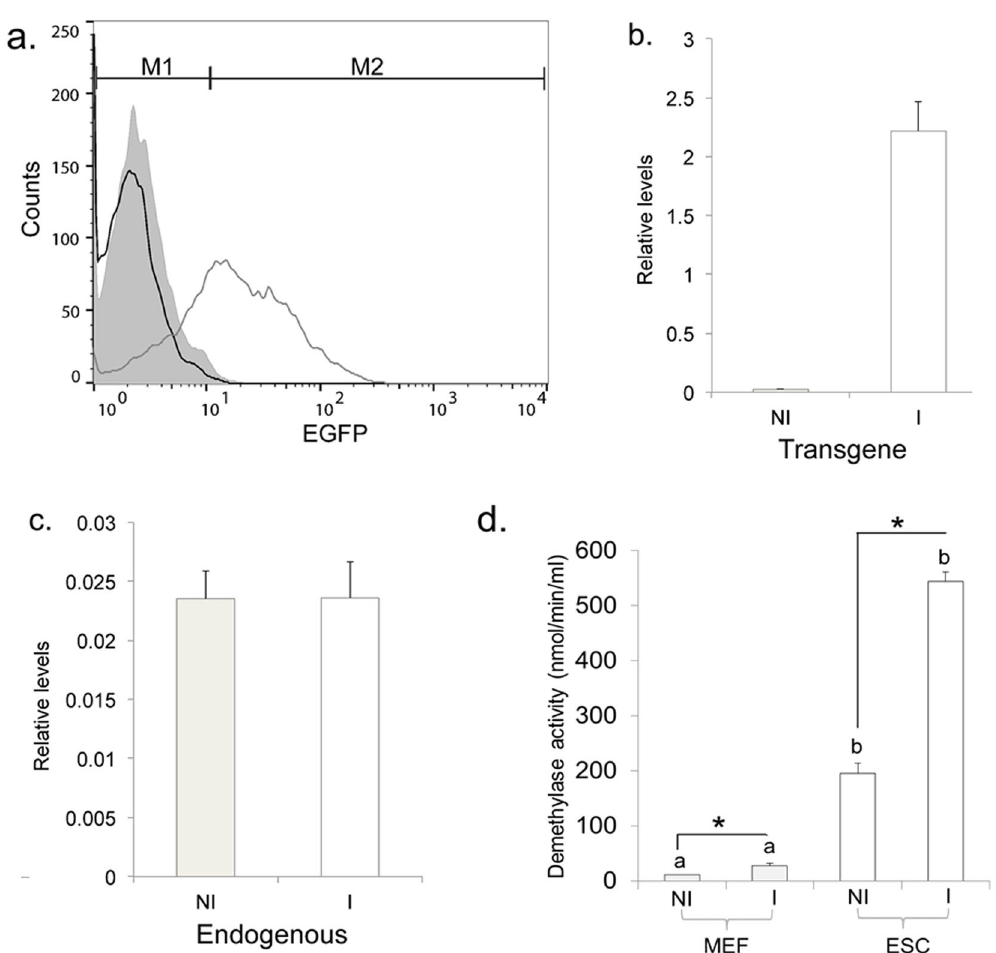
Figure 1. Characterization of inducible Kdm4b -EGFP expression. ( a ) Flow cytometry analyses of KDM4B- EGFP induction. Green fluorescence was determined using the FL1 EGFP emission channel. The range of intensities for green fluorescent cells (M2) is indicated. Relative cell number counts are plotted as a function of variable intensities of green fluorescence from individual cells. Black line graph: non-induced cells; grey line graph: induced cells; grey filled graph: induced cells 1 day after removal of doxycycline. ( b , c ) Kdm4b expression levels. Shown are the relative expression levels of transgene-derived Kdm4b ( b ) and endogenous Kdm4b ( c ) compared to the geomean of four housekeeping genes (n = 3 replicates). Results for non-induced (NI) and induced (I) F-Kdm4b MEFs are represented by grey and white bars ± SEM. ( d ) Demethylase activity in F-Kdm4b MEFs and ESCs. Results for non-induced (NI) and induced (I) F-Kdm4b MEFs and ESCs are represented by grey and white bars ± SEM, respectively (n = 3 replicates); Bars with an asterisk ( * ) differ P < 0.05 between treatments (NI vs I); bars with different letters ( a,b ) differ P < 0.05 between cell types (MEF vs ESC) of the same treatment by two-tailed unpaired